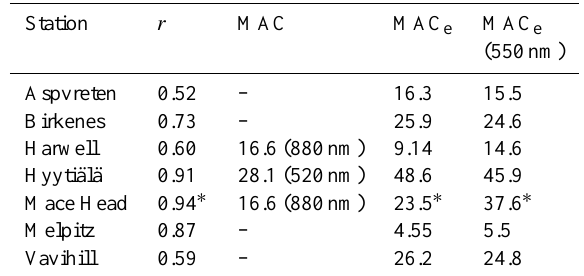
Table 2. Correlation between EC and BC (expressed as r values) and site-specific mass absorption cross sections (MAC) used in this study to form the EC-equivalent BC (BC e ) . MAC e values were ob- tained by normalising BC measurements with simultaneously ob- served EC. The normalization was done by minimizing the absolute deviation of the BC e from the observed EC (see text). The MAC e values adjusted to 550nm are also shown. EC in PM 10 was used in the calculations for all stations except Hyyti¨al¨a, for which EC in PM 1 was used.